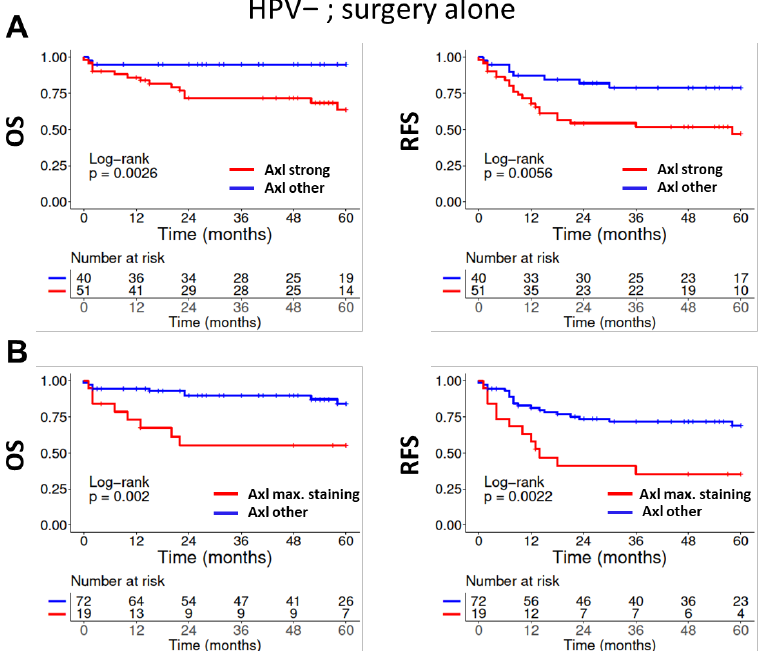
Figure 3. Association of patient survival and Axl expression in patients with HPV-negative tu- mors solely treated by surgery. ( A ) Axl-expression was categorized by the semiquantitative expres- sion score as either strong or other . ( B ) Axl expression was categorized by staining intensity. Only tumors showing the highest intensity (3) in more than 30% of tumor cells were categorized to the maximum (max.) staining group, which defines a smaller population than as compared to the strong expression score.